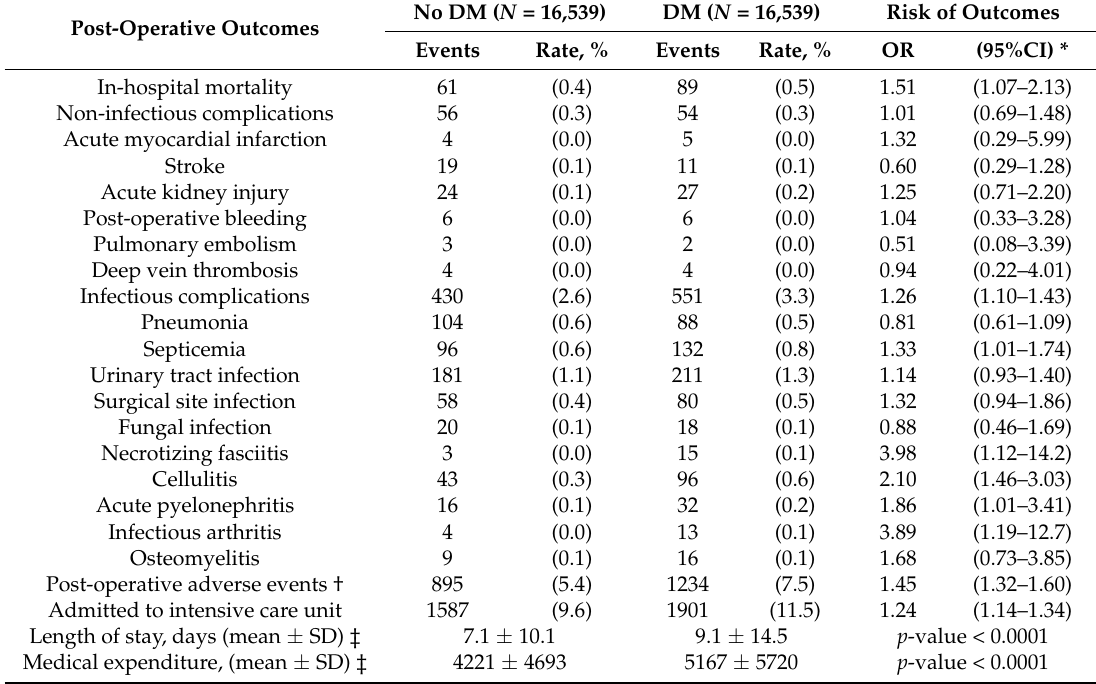
Table 3. Risks of post-operative complications and mortality outcomes of surgery patients after propensity score matching